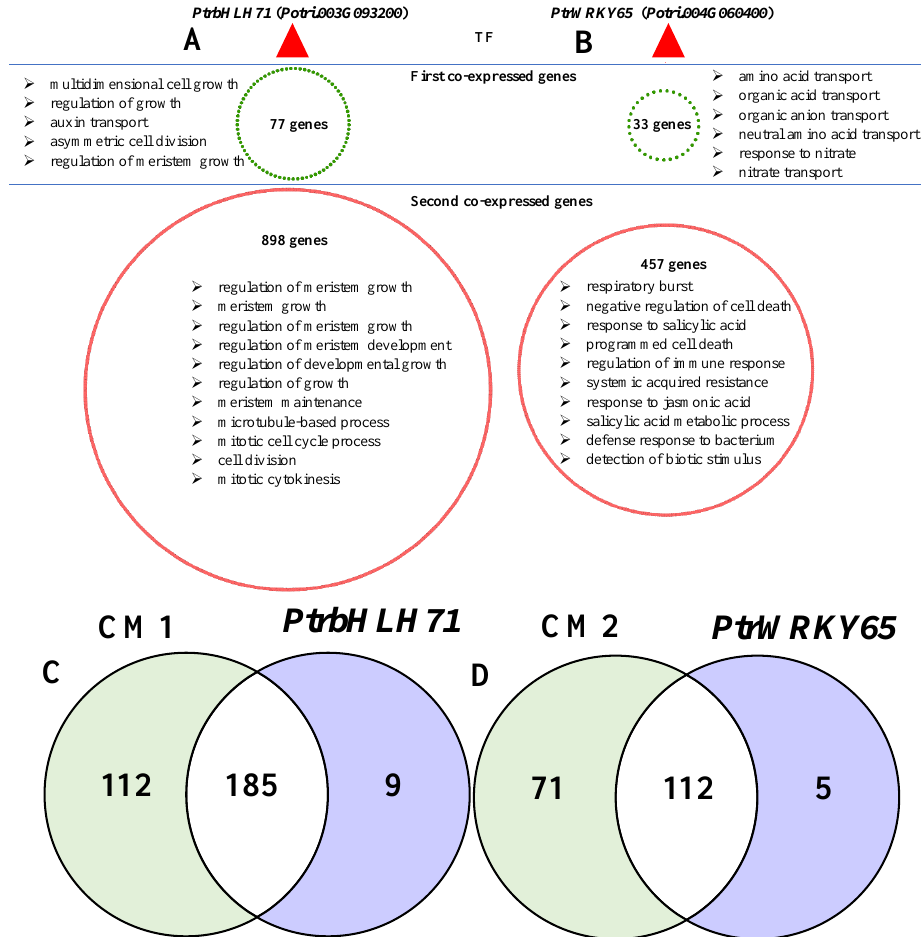
Figure 7. PtrbHLH71- centered ( A ) and ( B ) PtrWRKY65- centered gene regulatory networks derived Figure 7. PtrbHLH71 (A) and PtrWRKY65 (B) centered gene regulatory networks derived from CM1 and CM2, respectively. The transcription factors and their first and second co-expressed from co-expression module 1 (CM1) and CM2, respectively. The transcription factors as genes are presented. The edges were hidden for the better visualization. The represented significant well as their first and second co-expressed genes were showed. The edges were hidden for GO terms for the first/second co-expressed genes in the PtbHLH71- centered and PtWRKY65 -centered the better visualization. The represented significant GO terms for the first/second co- gene regulatory networks are indicated. Venn diagram representing the overlapping significant GO expressed genes in the PtbHLH71 and PtWRKY65 centered gene regulatory networks were terms in biological processes between CM1 and the PtbHLH71 -centered network ( C ) and between CM2 indicated, respectively. Venn diagram represented the overlapping significant GO terms in and the PtWRKY65 -centered network ( D biological process between CM1 and PtbHLH71 centered network (C), as well as between CM2 and PtWRKY65 centered network (D).